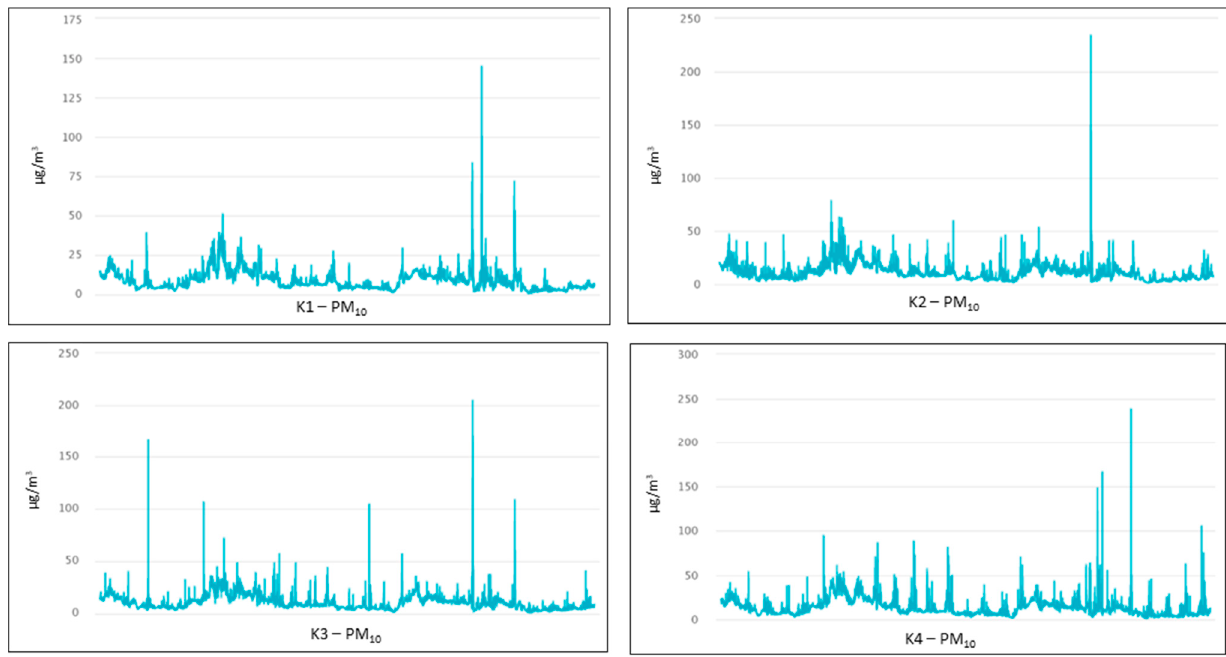
Figure 4. PM 10 mass concentration in μ m/m 3 as (10 min) time series for each of 4 measurement locations K1, K2, K3, and K4 for the measuring period from 20 August to 15 September 2022. For the same experimental period, the 24 h average values of PM 2.5 and PM 10 were determined by each measurement station. The daily averages of PM 2.5 at each location